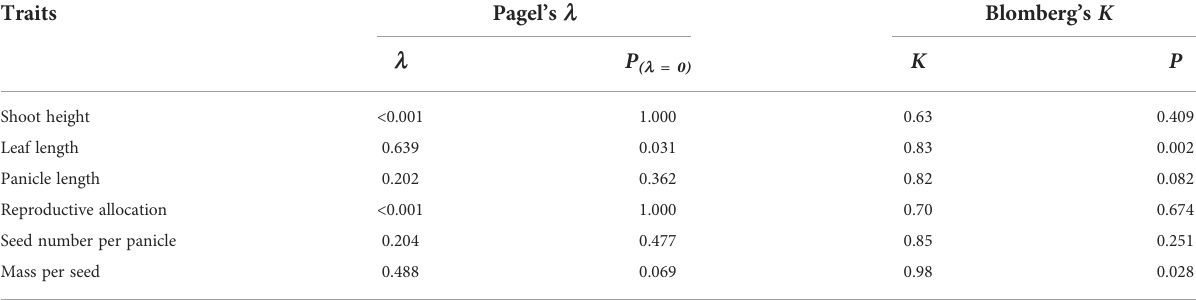
TABLE 4 Phylogenetic signals of functional traits in Phragmites australis traits.